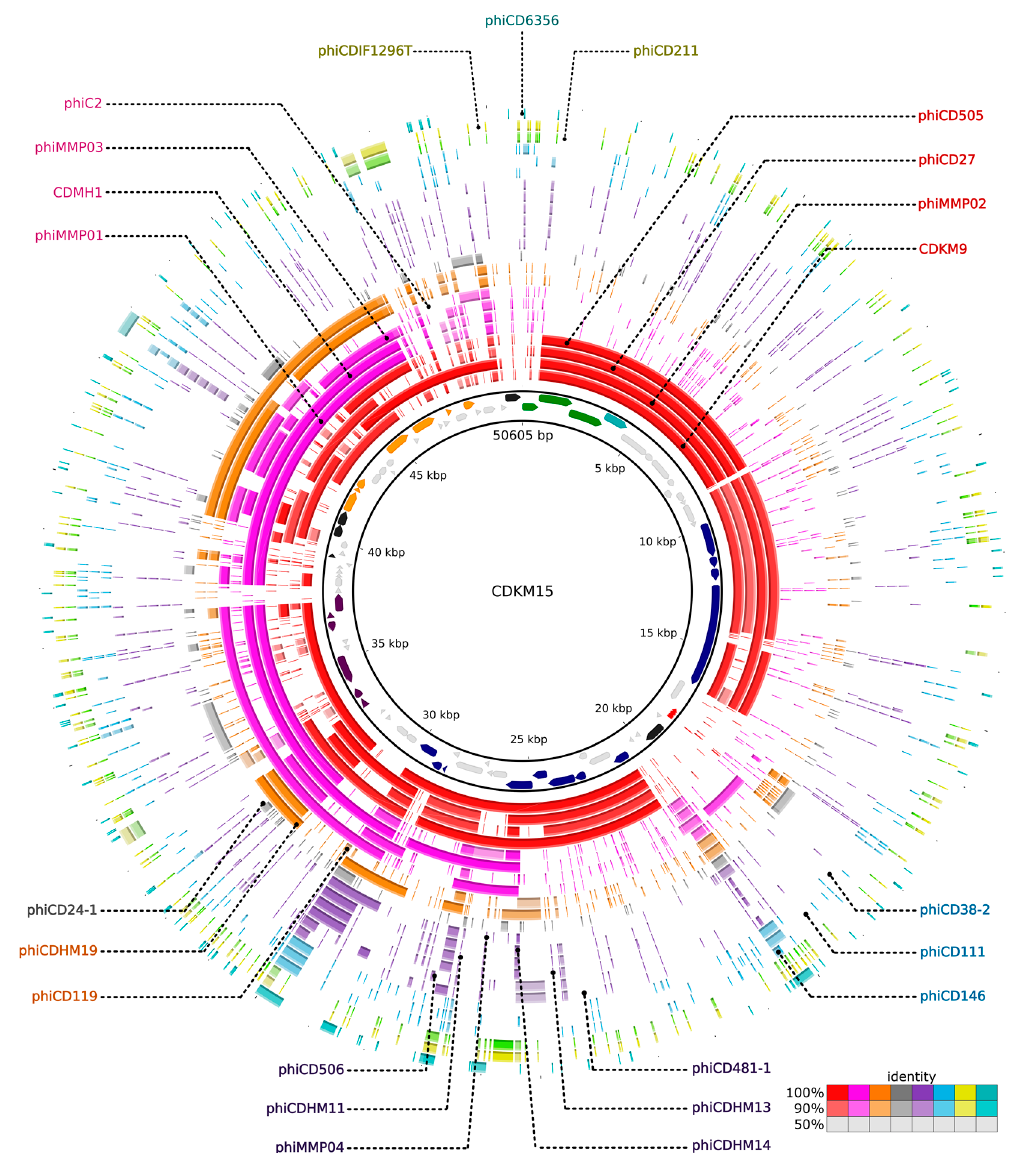
Figure 8. Whole genome comparison of CDKM15 and C. difficile phages. The local similarity of each phage is calculated based on BLASTn high scoring pairs and plotted against a circular map of the reference genome represented as the inner circle (in this case genome of CDKM15). Similarity to each of the 23 C. difficile phages is shown as colouring intensity in consecutive rings. Outer rings are coloured consistent to the scheme in Figure 6.